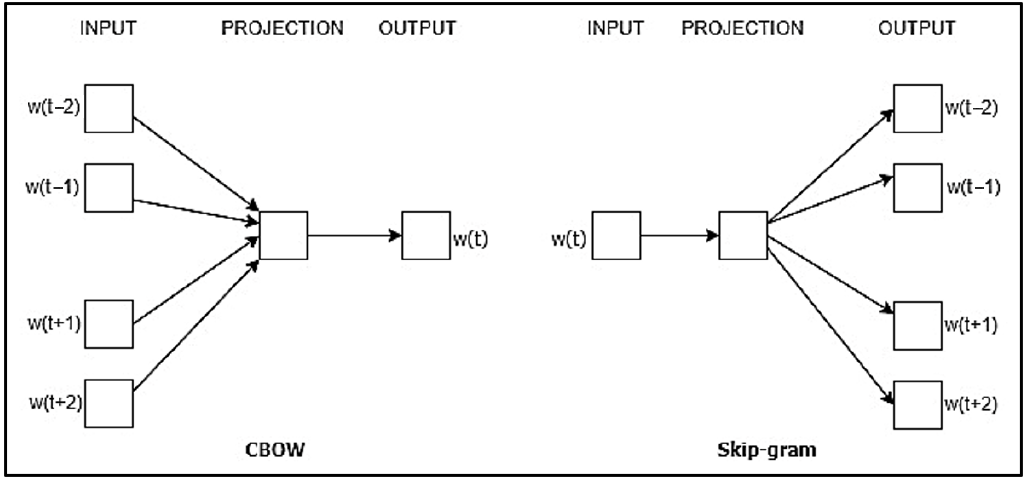
Figure 2. The architecture of CBOW and SG models.